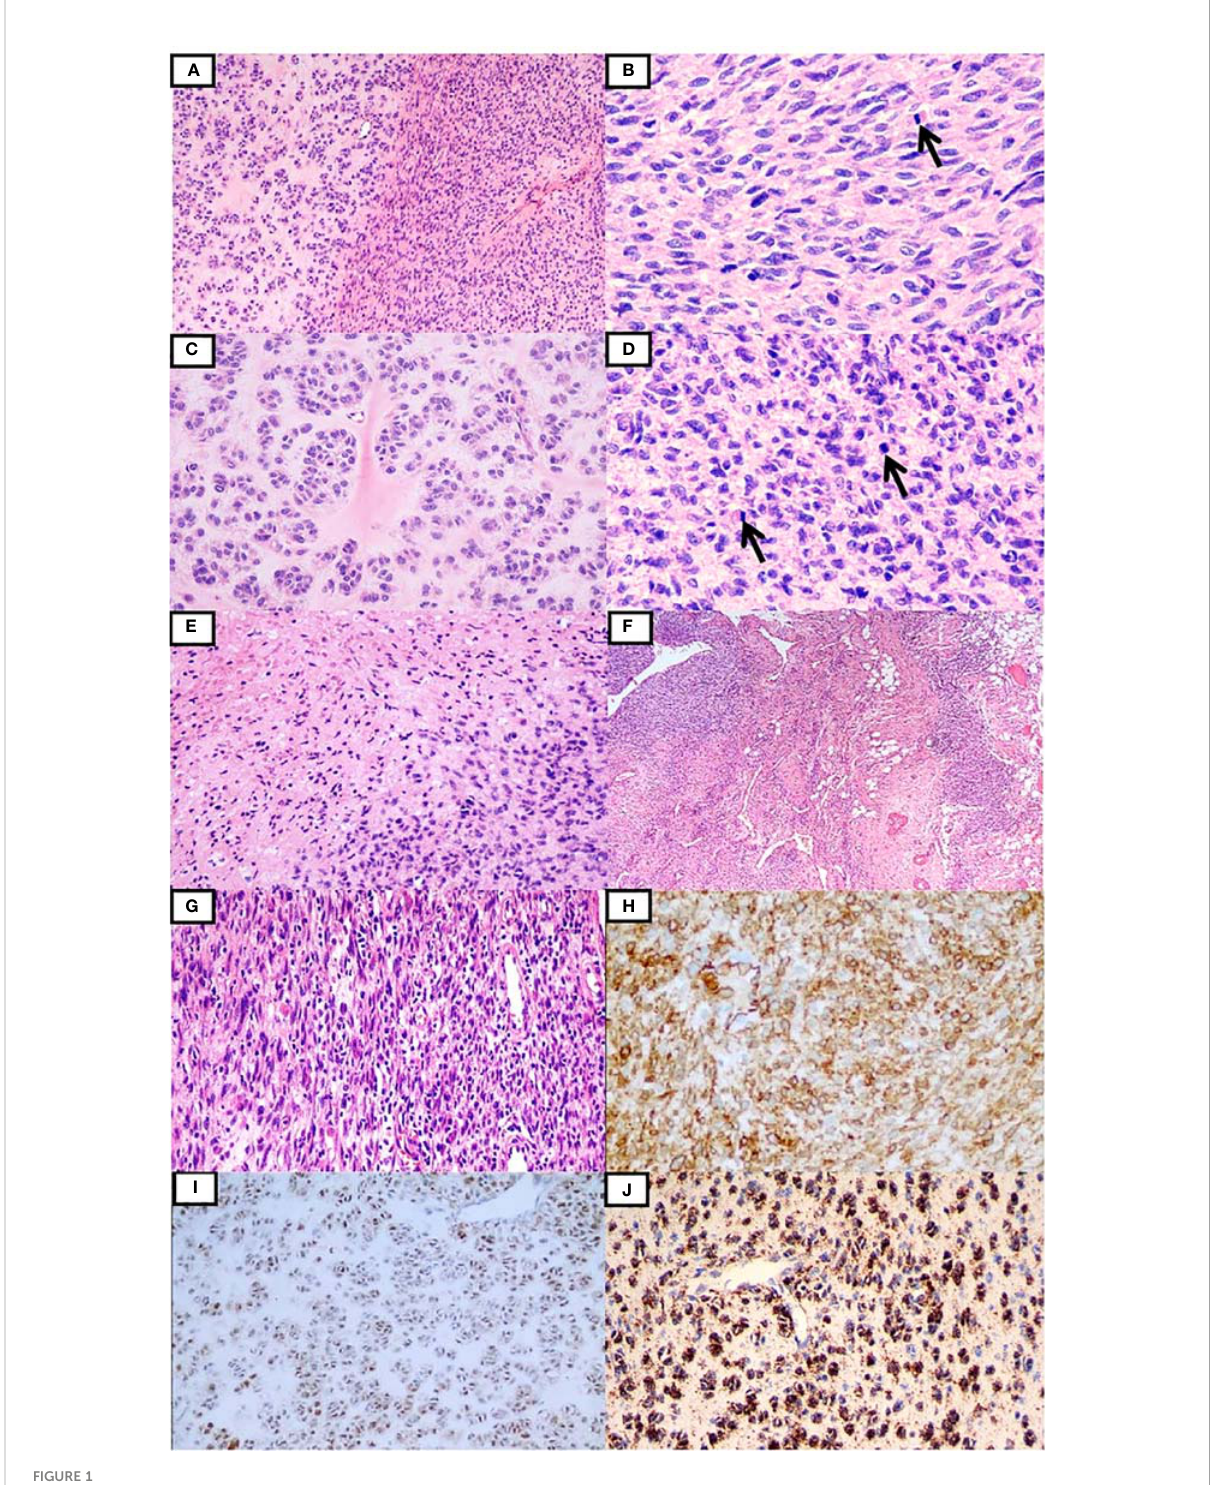
FIGURE 1 Clinicopathological fi ndings of the tumor in case 1. The tumor was composed of the spindle and epithelioid cells embedded in myxedematous and hyalinized stroma (A) . The spindle cells were focally arranged in the intersecting fascicles with frequently observed mitotic fi gures (B) , while the epithelioid cells were arranged in the nest- or cord-like pattern in the myohyaline background (C) . In some areas, the tumor cells were more cellular with relatively brisk mitoses (D) . Focal necrosis was recognized (E) . Tumor cells in fi ltrating the surrounding adipose tissues and thin-walled branching vessels were seen (F) . In fl ammatory cell in fi ltration was observed locally (G) . Tumor cells were positive for CD34 (H) , S100 (I) , and ALK-D5F3 (J)